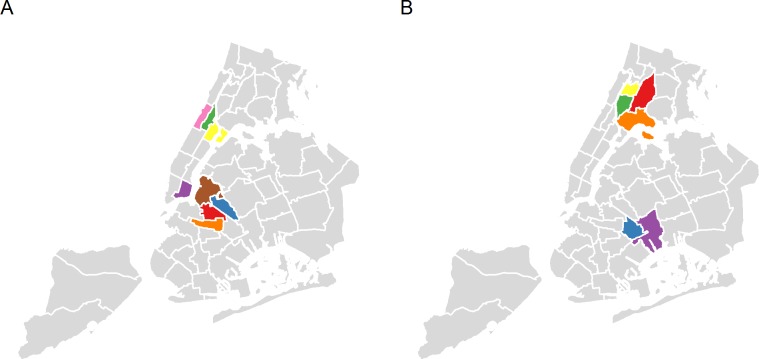
Gentrifying and non-gentrifying, poor neighborhoods, New York City, 2005–2014.Legend: (A) Gentrifying neighborhoods included Crown Heights North and Prospect Heights (orange color); Bedford-Stuyvesant (red color); Chinatown and Lower East Side (purple color); Bushwick; Greenpoint and Williamsburg (blue color); Hamilton Heights and West Harlem (pink color); Central Harlem (green color); and East Harlem (yellow color). (B) Non-gentrifying, poor neighborhoods included East New York and Starrett City (purple color); Morris Heights and Fordham South (yellow color); Brownsville and Ocean Hill (blue color); Hunts Point, Longwood and Melrose (orange color); Belmont, Crotona Park East, and East Tremont (red color); and Concourse, High bridge and Mount Eden (green color). Notes: Gentrifying neighborhoods were defined as having a low ranking in 2005 in median household income, median gross rental price, and proportion of adults aged 25 or older with a college degree, and a high ranking in the growth of these variables during 2005–2014; non-gentrifying, poor neighborhoods were defined as having a low ranking in the same set of variables in 2005 and a low ranking in the growth.